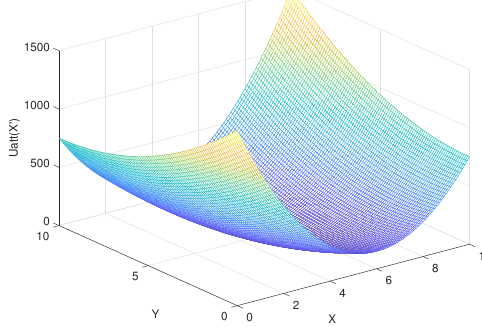
Figure 9. The influence of δ change rate on U att .